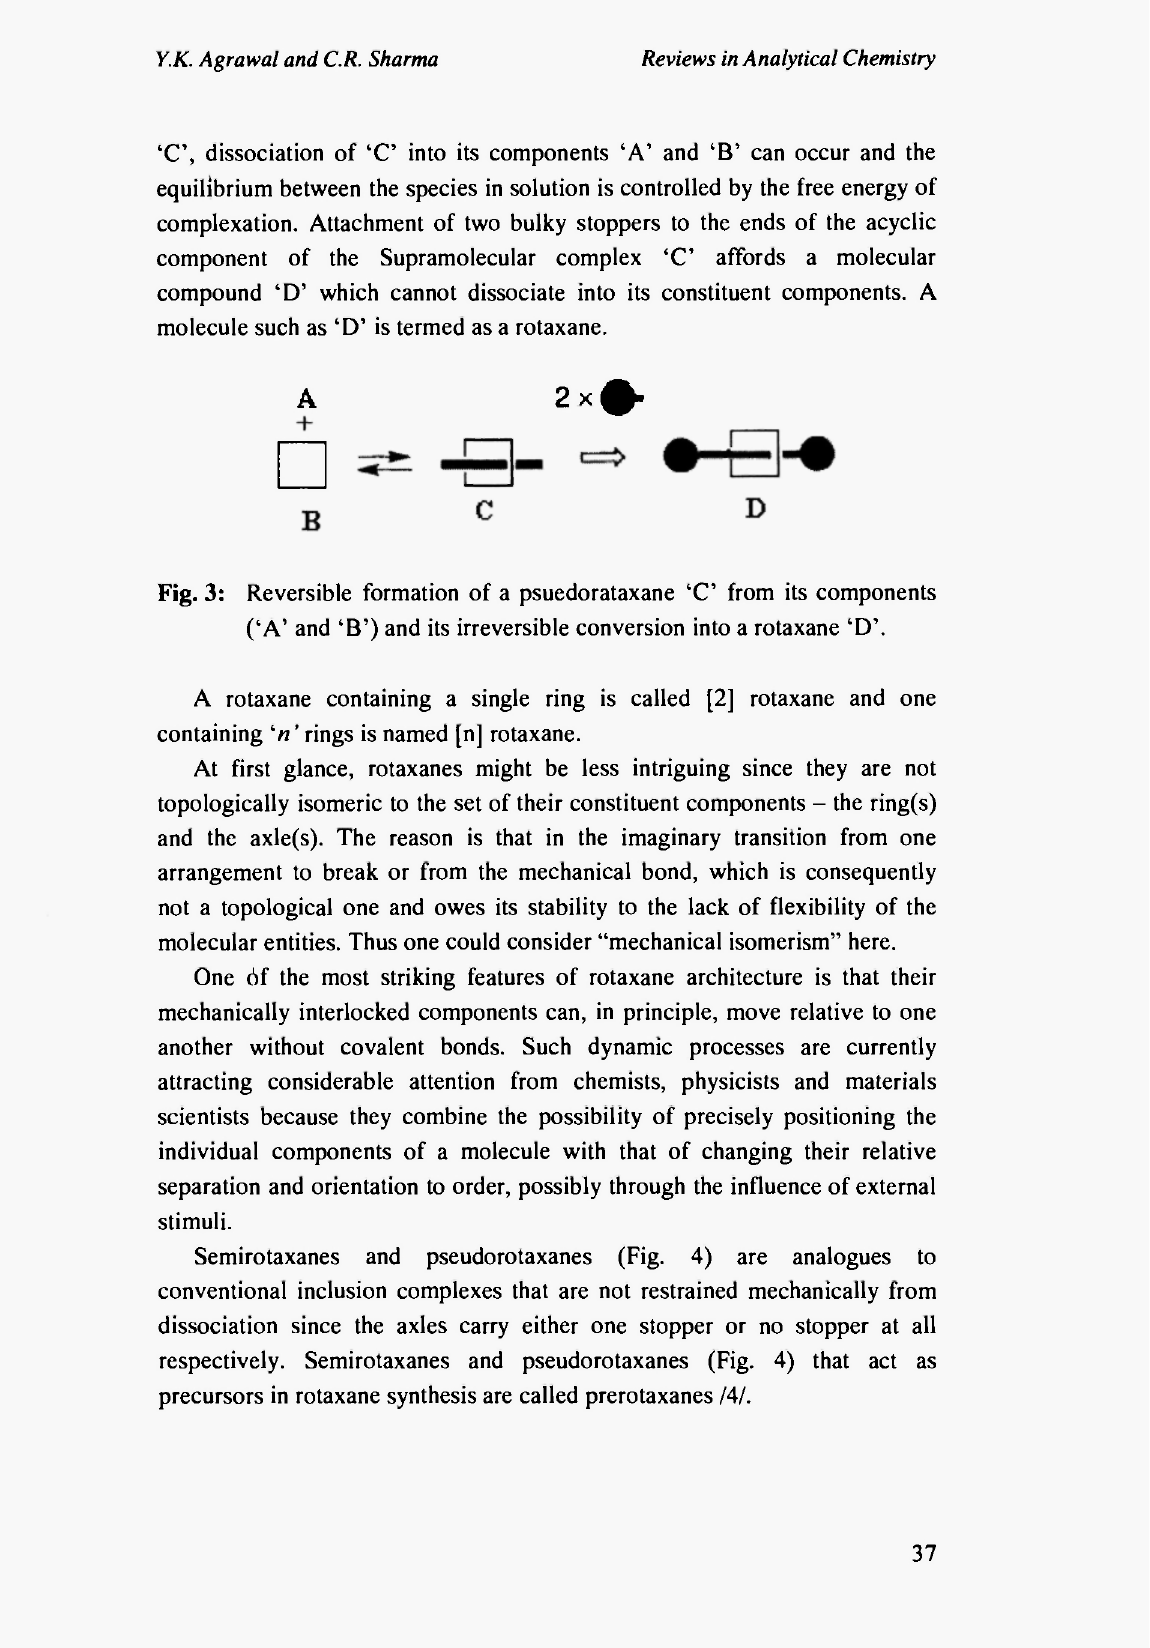
Fig. 3: Reversible formation of a psuedorataxane 'C' from its components ('A' and Έ ') and its irreversible conversion into a rotaxane